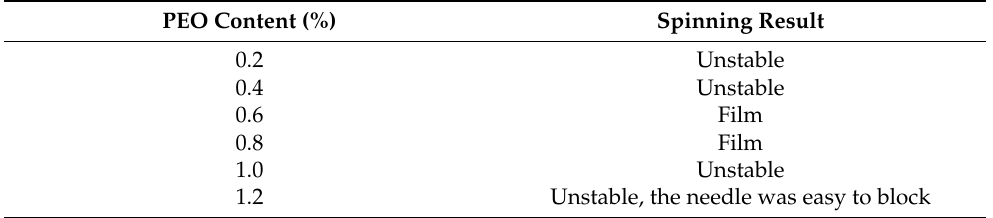
Table 1. Effects of PEO content on